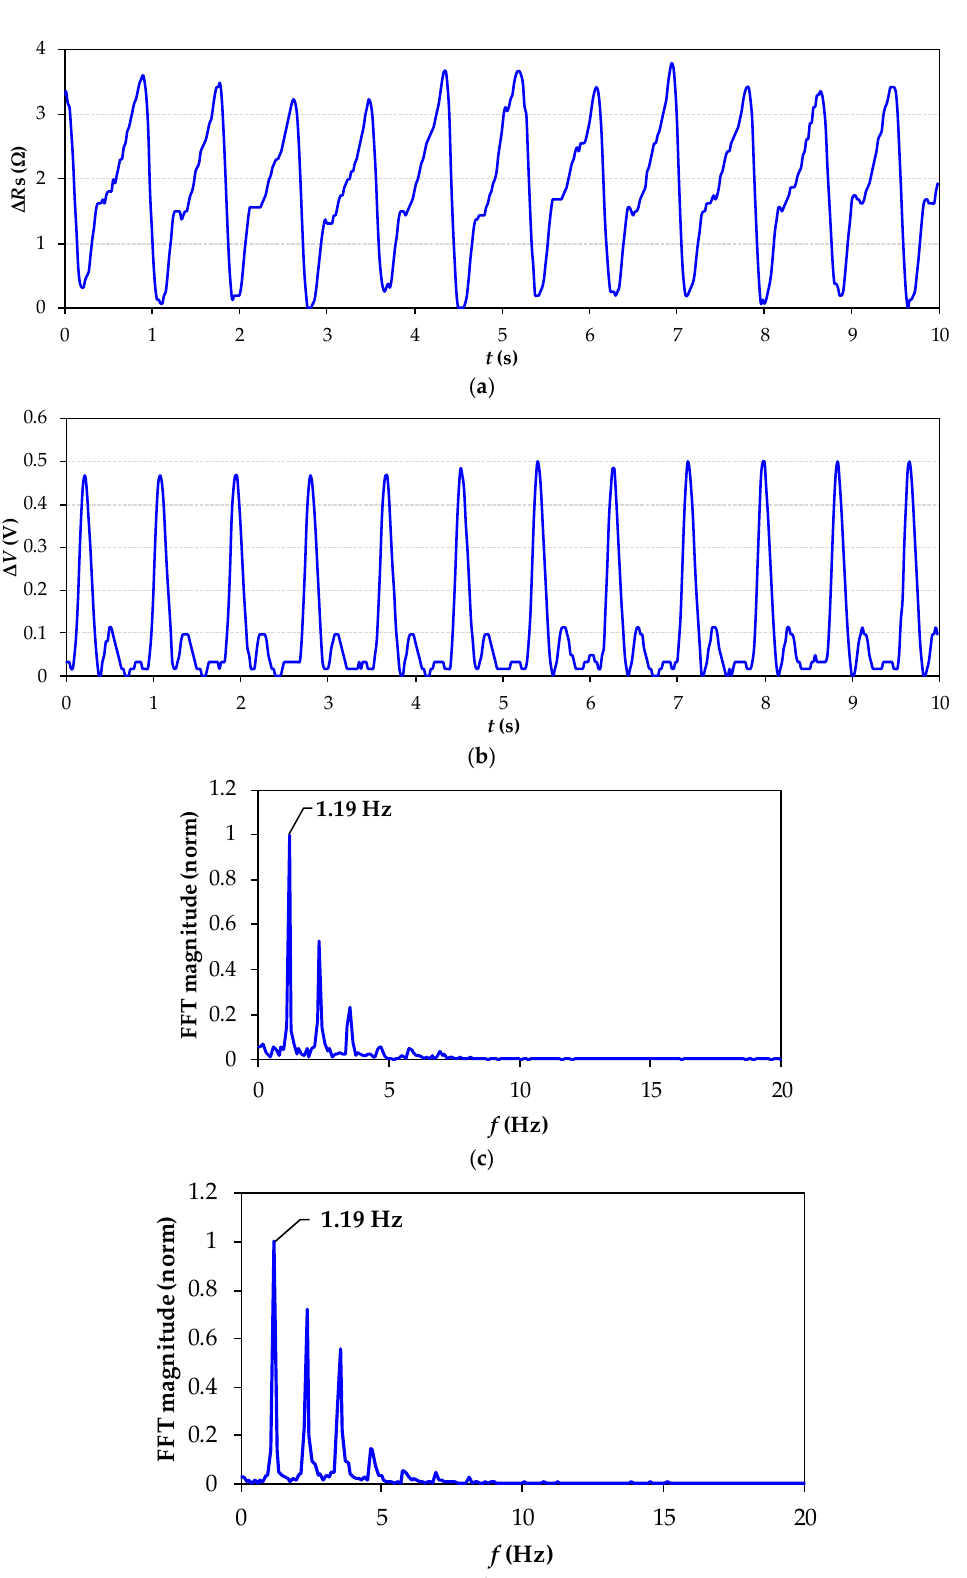
Figure 7. Experimental heartbeat signal from S2. ( a ) Resistance variations in FSR measured by the DIC when the sensor was located near the radial artery; ( b ) voltage variations in the commercial heart rate monitor; ( c ) frequency spectrum of the FSR signal; ( d ) frequency spectrum of the commercial monitor signal.